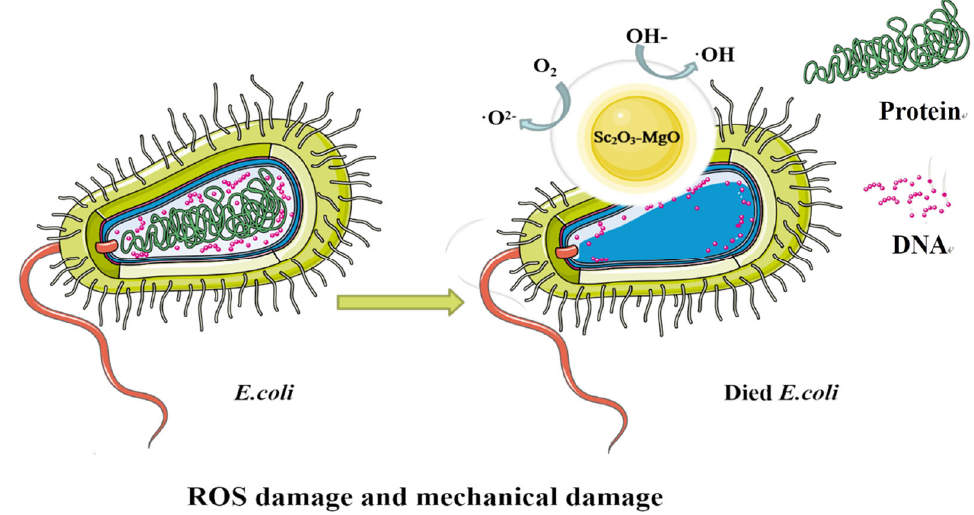
Figure 6. Antibacterial mechanism of Sc 2 O 3 ‐ MgO.